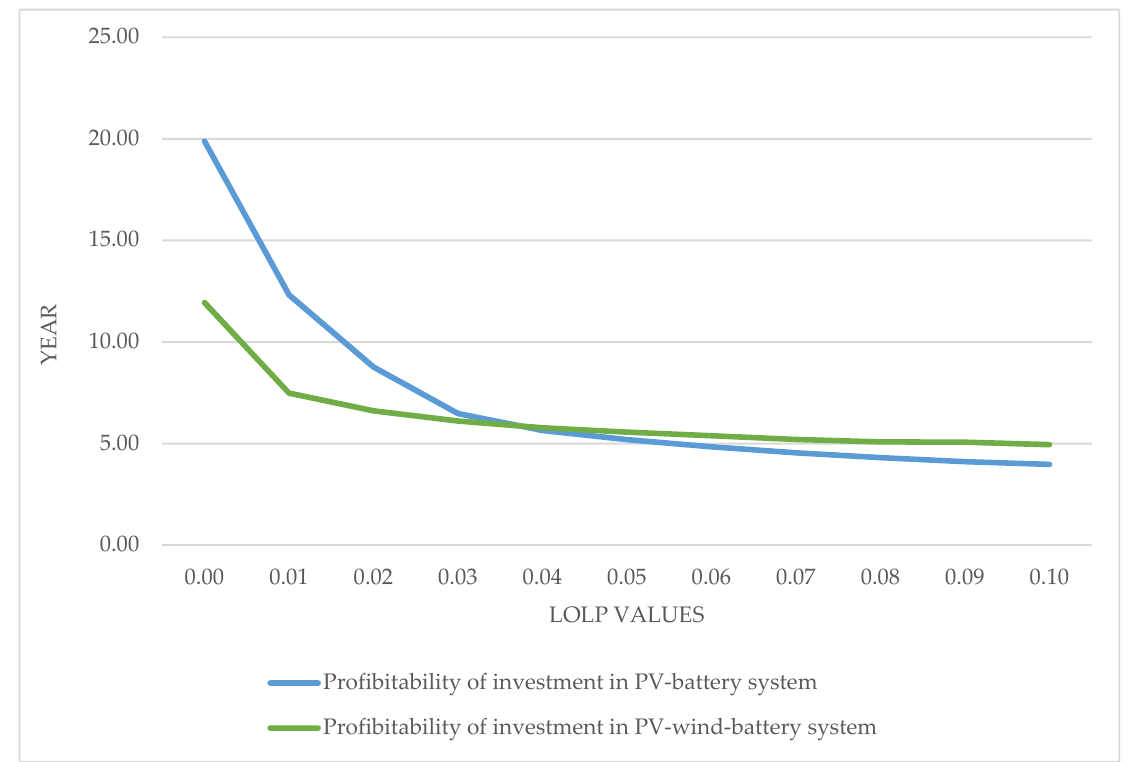
Figure 6. Profitability of investment regarding both scenarios.